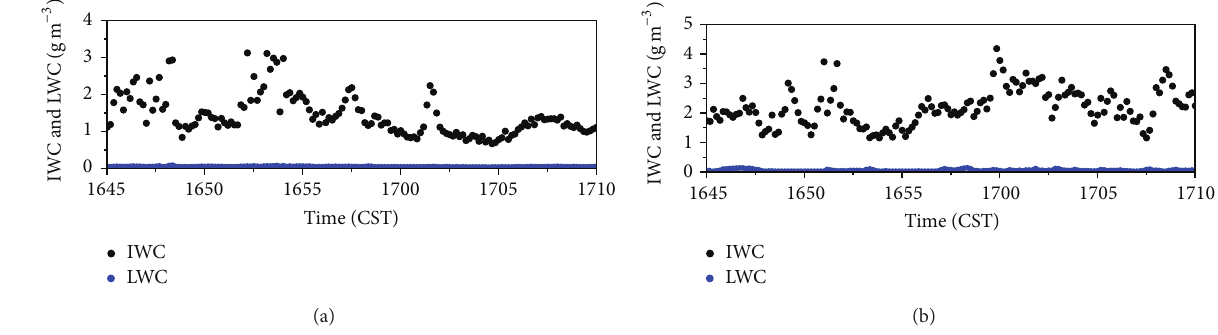
Figure 4: Time series of IWC (black) and LWC (blue) across flight legs (a) 2 and (b)